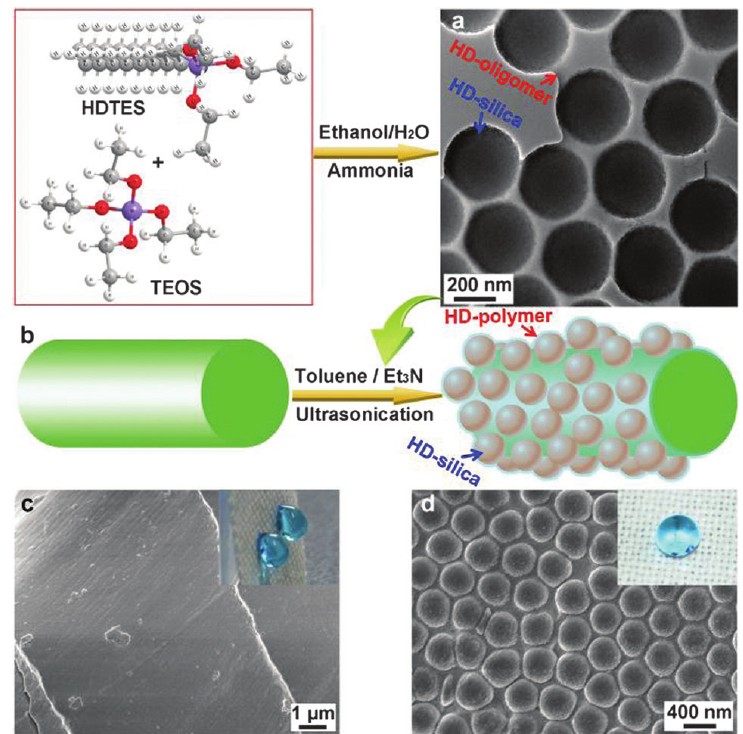
Figure 8. ( a ) Preparation of HD-oligomer/HD-silica nanocomposite; ( b ) Scheme for the super- Figure 8. ( a )PreparationofHD-oligomer / HD-silicananocomposite; ( b )Schemeforthesuper-hydrophobic hydrophobic fabric preparations; ( c ) SEM images of pristine and ( d ) HD-polymer/HD-silica coated fabric preparations; ( c ) SEM images of pristine and ( d ) HD-polymer / HD-silica coated superhydrophobic superhydrophobic wool fabrics (Reproduced from [41], with kind permission of Royal Society of wool fabrics (Reproduced from [41], with kind permission of Royal Society of Chemistry).